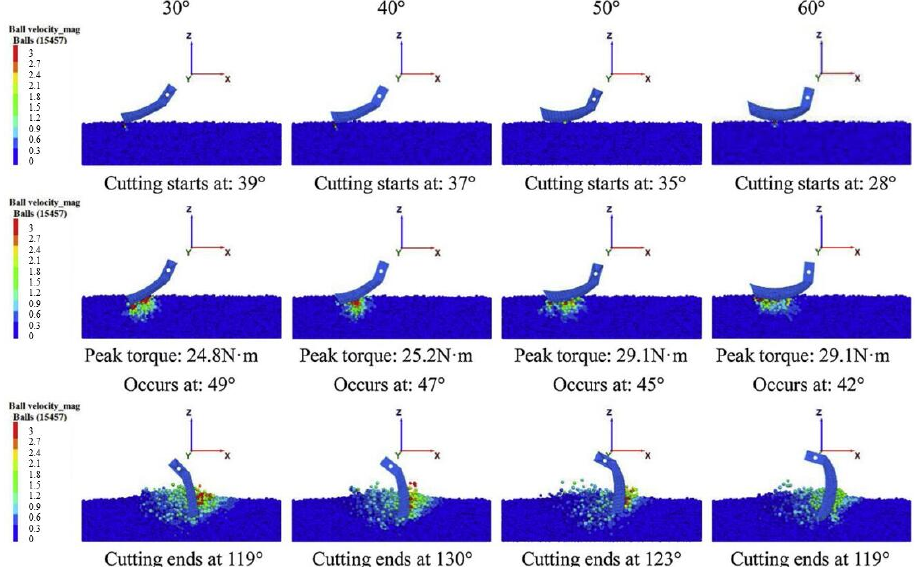
Figure 4. Connection parts 6 order mode shape diagram [73] ( a ) 1-order mode shape diagram; ( b ) 2-order mode shape diagram; ( c ) 3-order mode shape diagram; ( d ) 4-order mode shape diagram; ( e ) 5-order mode shape diagram; ( f ) 6-order mode shape diagram.